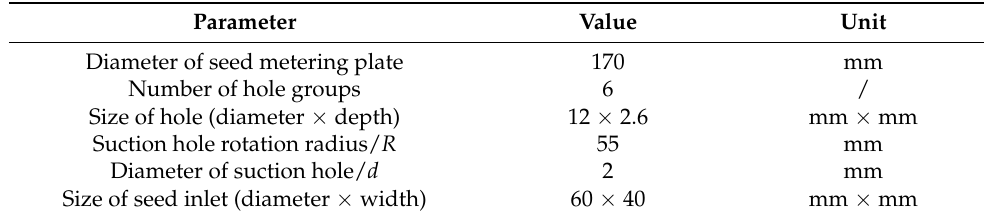
Table 1. The structural parameters of key